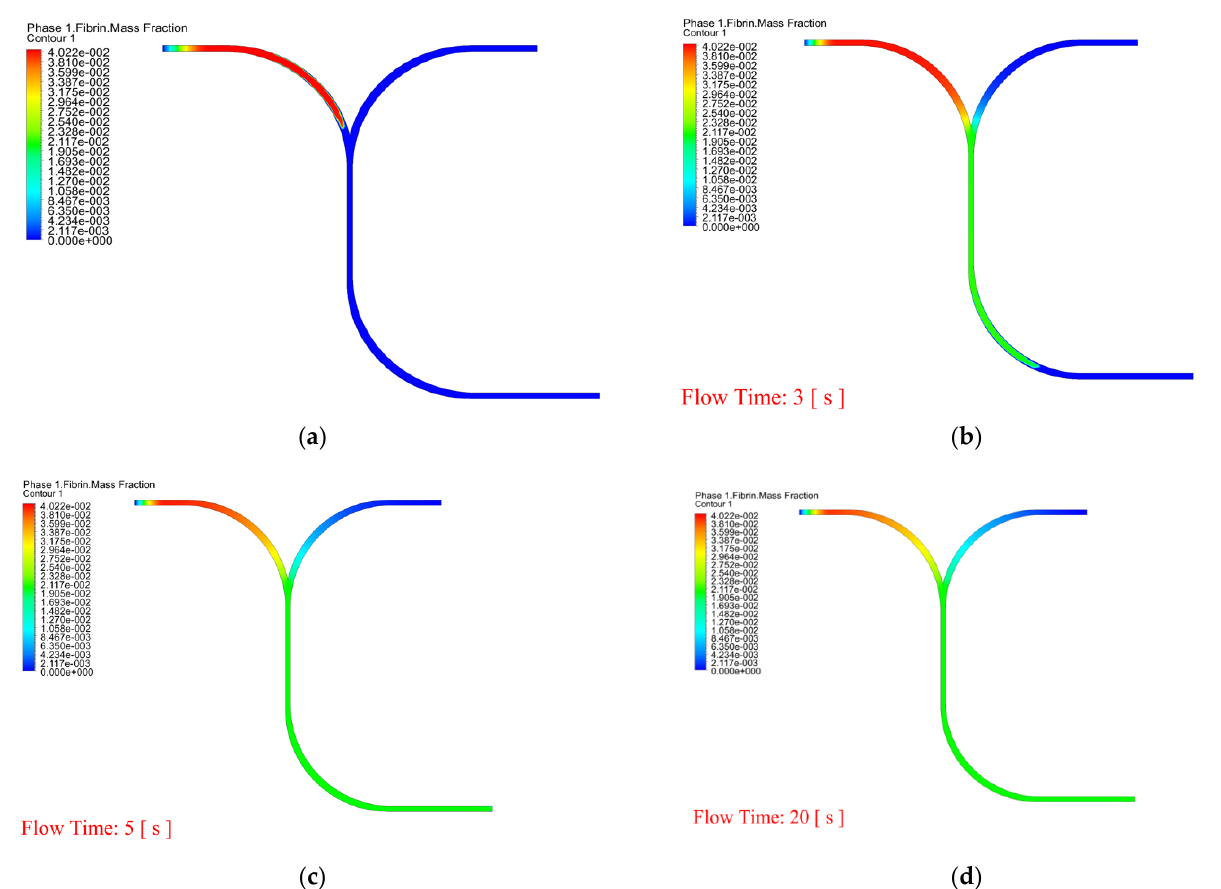
( d ) Figure 6. Mass fraction of the prothrombin activator in the microchannel at various times ( a ) 1 s, ( b ) 3 s, ( c ) 5 s, and ( d ) 20 s. As indicated by Equations (16) and (17), thrombin and fibrin in the blood undergo